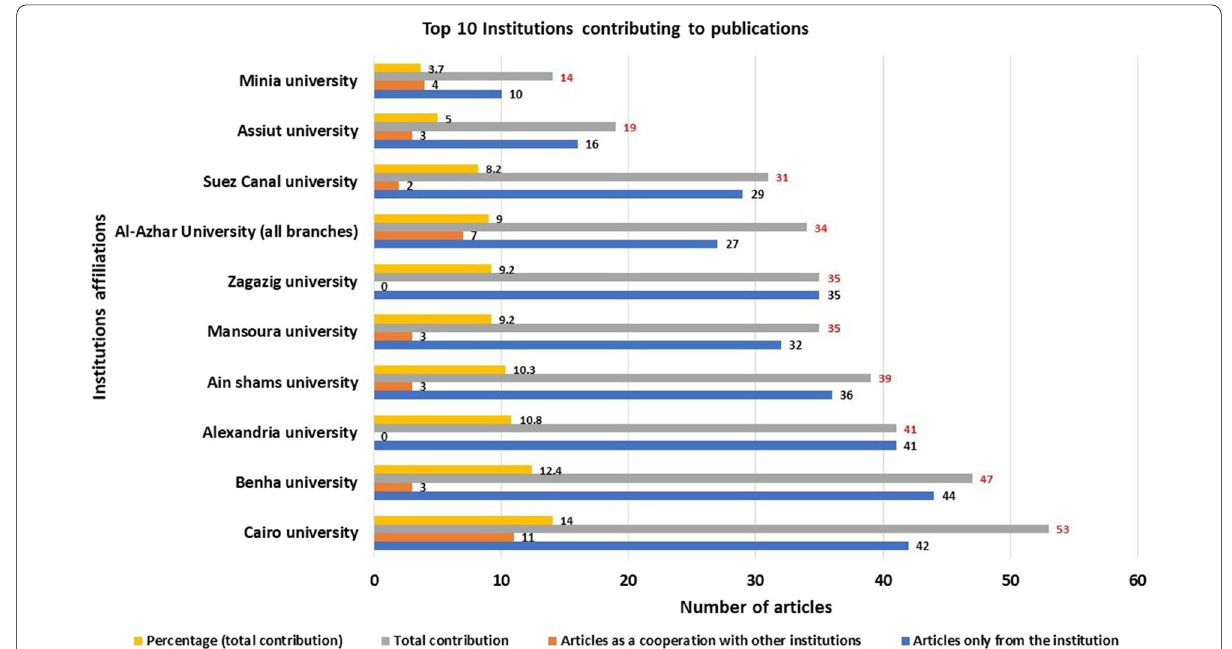
Fig. 2 Top 10 contributing institutions to the journal